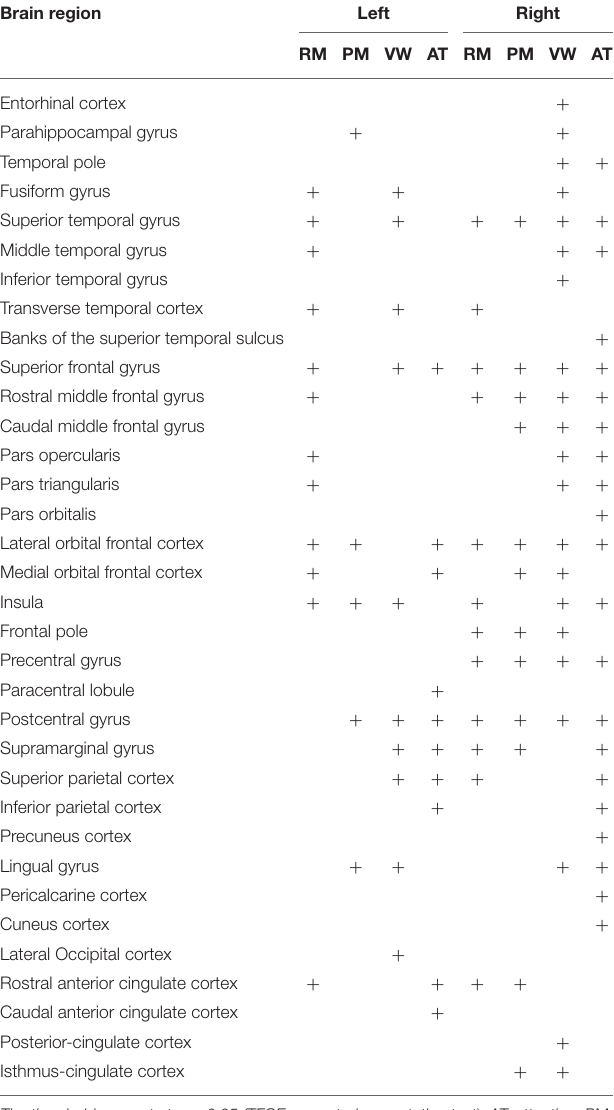
TABLE 6 | Cortical fractal dimension correlated with each factor score. Brain region Left Right RM PM VW AT RM PM VW